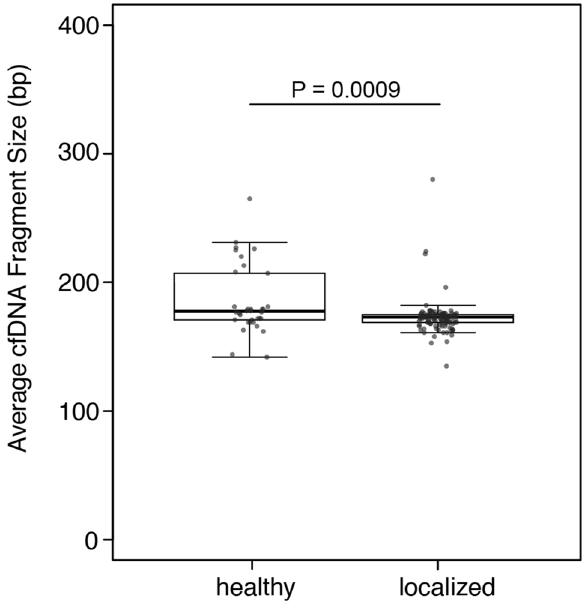
Figure 3. Distribution of average fragment size in healthy individuals and patients with localized disease (P = 0.0009). Boxplots and points identify the minimum, interquartile range, median, and maximum values for each group. A Mann–Whitney U-test was performed to test the difference in cfDNA fragment